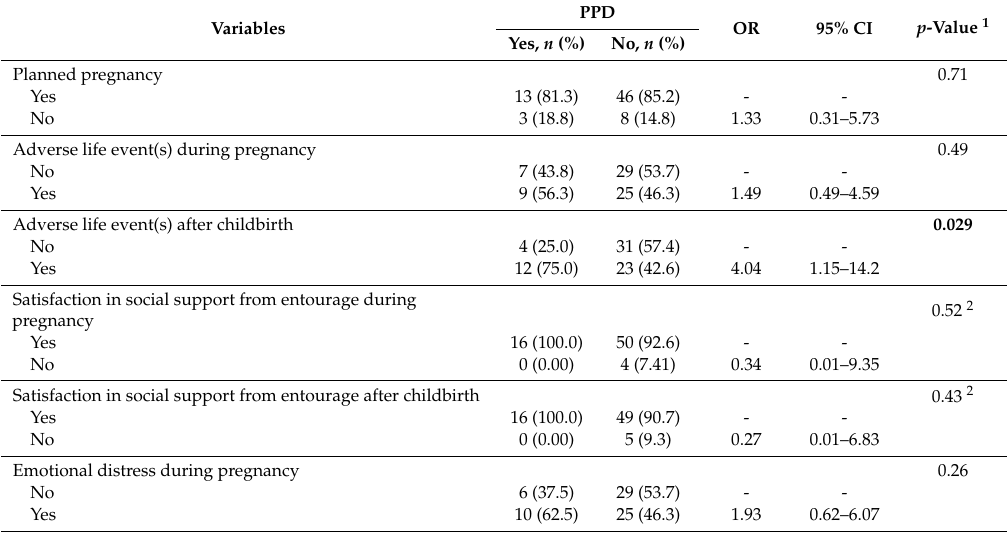
Table 2. Univariate logistic regression model associating postpartum depression (PPD) with potential risk factors. Odds ratio (OR), confidence interval